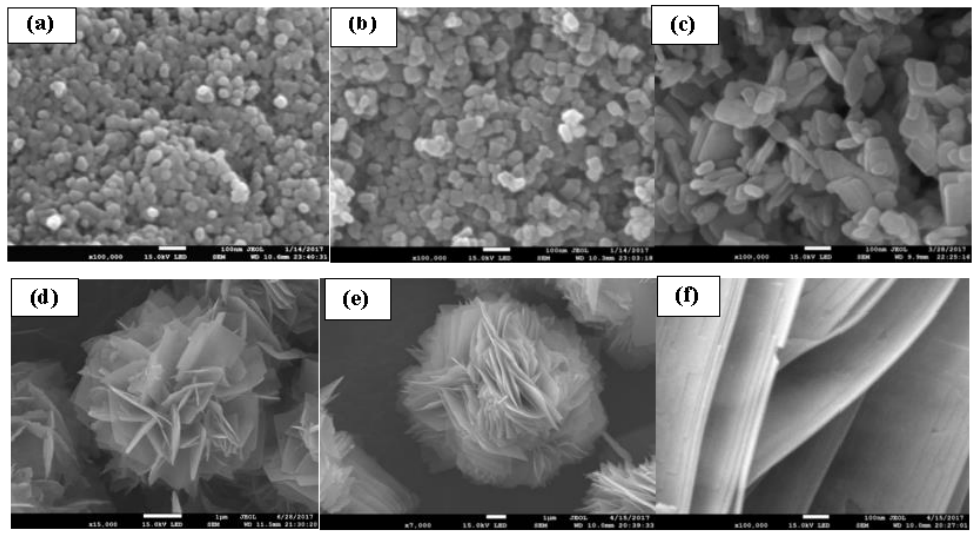
Figure 10. SEM images of TiO 2 samples prepared with different amounts of HF: ( a ) pure-TiO 2 , ( b ) T-1F, ( c ) T-3F, ( d ) T-5F, ( e ) T-7F, and a high magnification image of ( f ) T-7F [114].